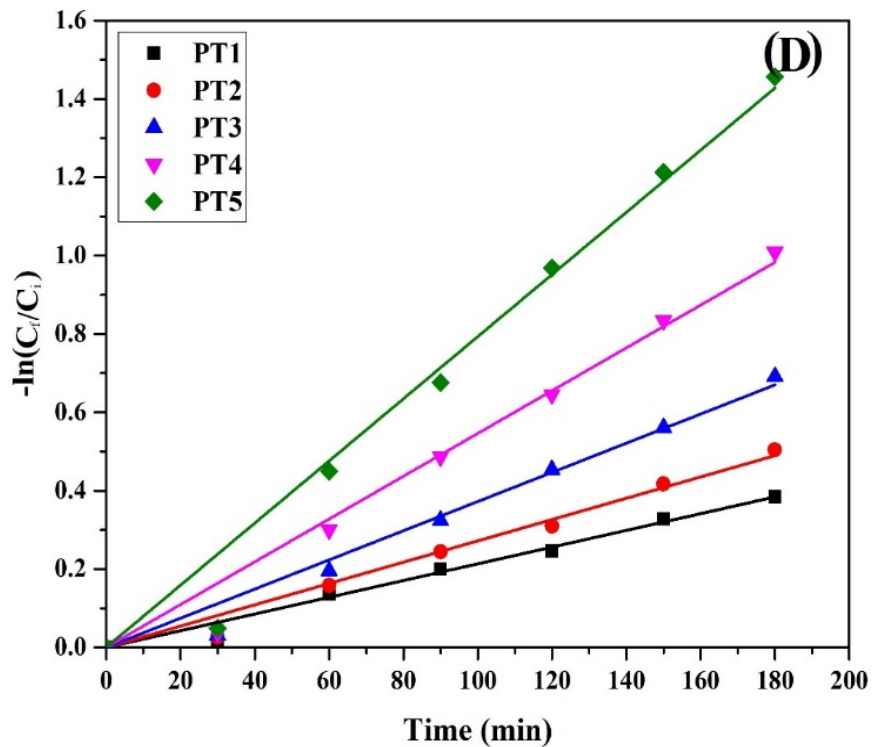
Figure 8. Temporal variation of normalized dye concentration in the permeate obtained from the plain and the modified PVDF membranes: ( A ) RB ( C ) MO; Natural log plots of normalized dye concentration in the permeate obtained from the plain and the modified PVDF membranes against time to compute rate constants: ( B ) RB ( D ) MO.